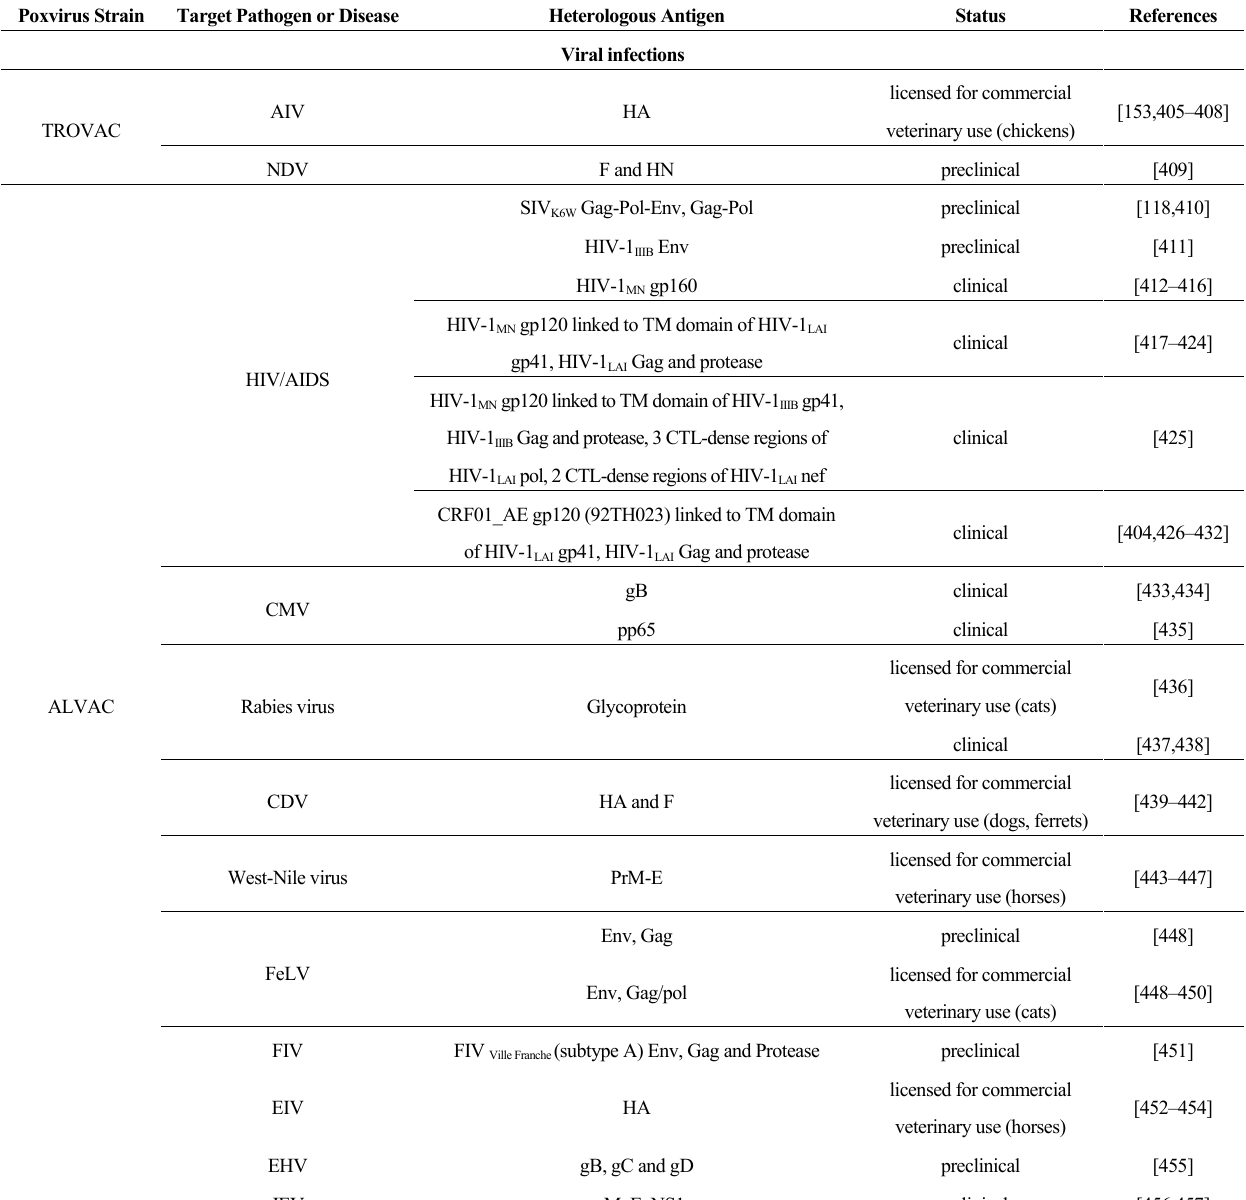
Table 7. Vaccine applications of attenuated avipoxvirus-based